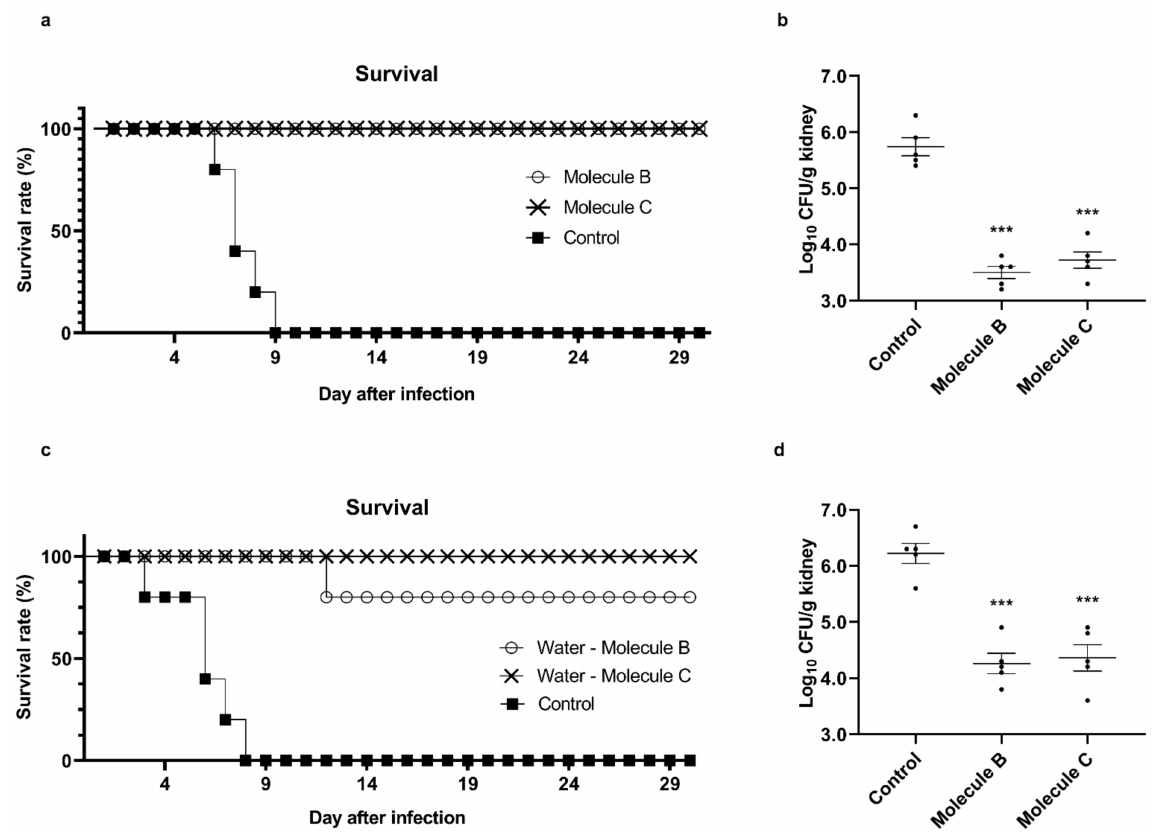
Figure 3. Attenuation of C. albicans pathogenicity by Molecule B and Molecule C treatment in the candidiasis murine model. The candidiasis mouse model was established by the inoculation of 5 × 10 6 cells of C. albicans SC5314 through tail vein injection. ( a ) From the day after C. albicans infection to the 30th day, Molecule B and Molecule C were injected at 8 and 16 mg/kg, respectively, via tail vein injection, and the survival rate was measured every day. ( b ) The dead mice were dissected, the kidneys were harvested, weighed, washed with PBS, chopped, spread on YPD plates, and incubated at 30 ◦ C for 2 days, and then the CFUs were counted to analyze the burden of fungal infection. Each Log 10 CFU value is indicated by a dot, and the mean and standard error values are indicated by a horizontal line. ( c ) For 1 month from the day after C. albicans infection, Molecule B and Molecule C were diluted to 8 and 16 mg/L, respectively, in the drinking water of the mice, and the survival rate was measured every day after allowing the mice to ingest autonomously. ( d ) The dead mice were dissected, the kidneys were harvested, weighed, washed with PBS, chopped, spread on YPD plates, and incubated at 30 ◦ C for 2 days, and the CFUs were counted to analyze the fungal infection burden. Each Log 10 CFU value is indicated by a dot, and the mean and standard error values are indicated by a horizontal line. *** p < 0.001 ( t